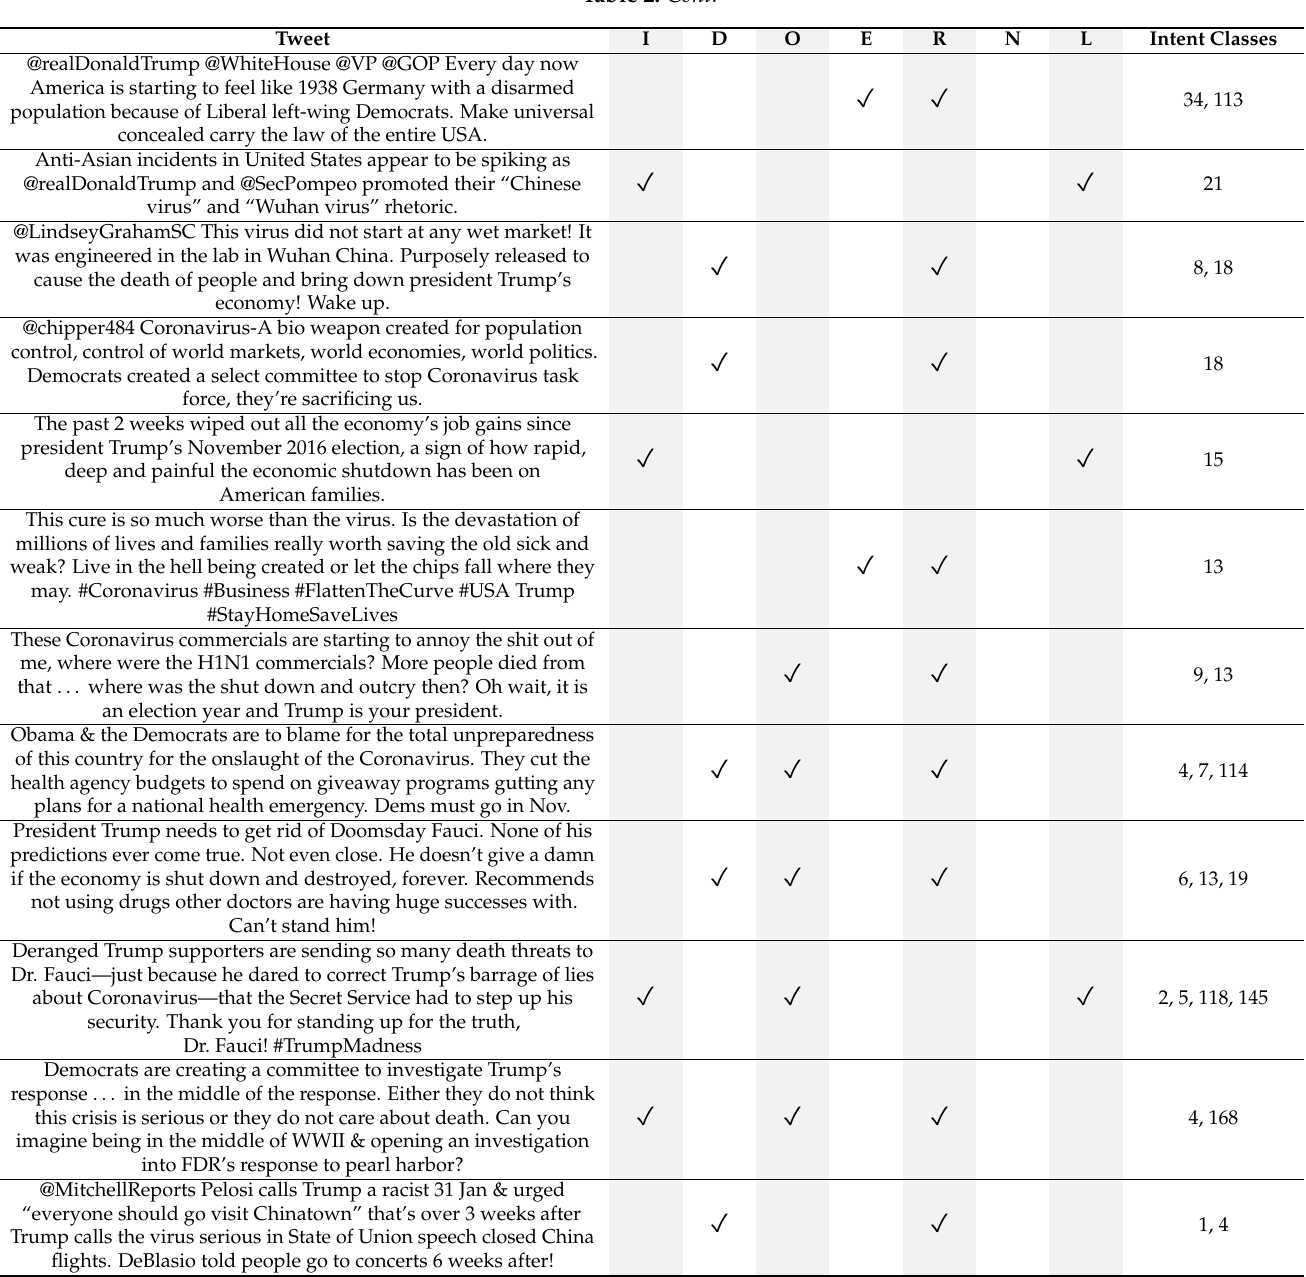
Table 2. Example Tweets and their classes: I stands for information, D for disinformation, O for opinion, E for extreme opinion, R for rightist, N for neutral, and L for leftist.